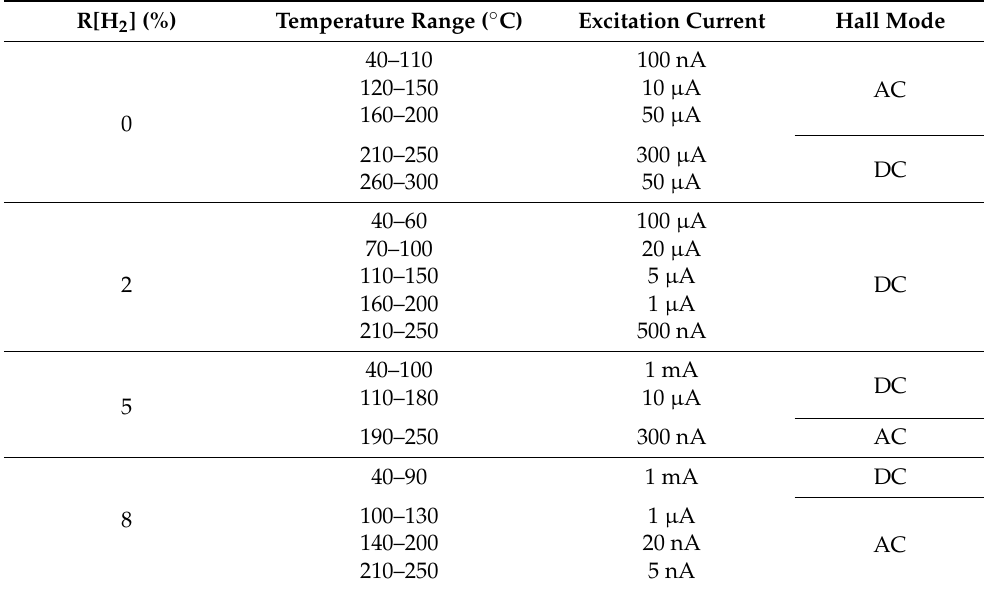
Table A1. In situ Hall measurement parameters utilized for analysis of the conventional and hydrogen-containing IGZO films performed in air